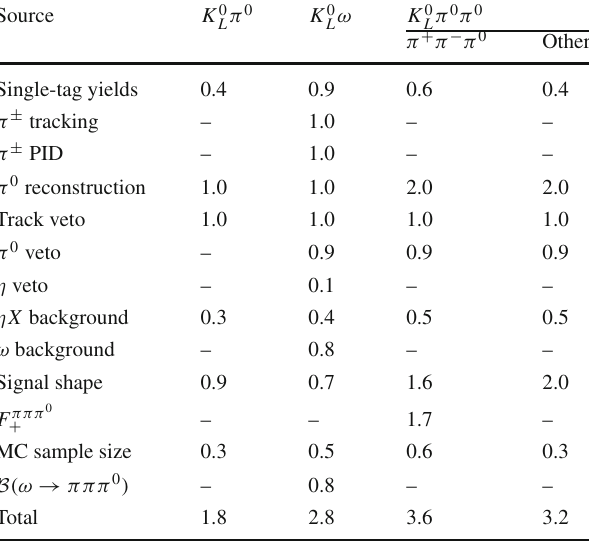
Table 1 Systematic uncertainties for the D → K 0 X branching frac- L π 0 π 0 the results are shown separately for events tions. For D → K 0 L tagged with D → π + π − π 0 decays and with other modes. Entries marked with ‘-’ are where the source is not relevant. All uncertainties are relative and given in